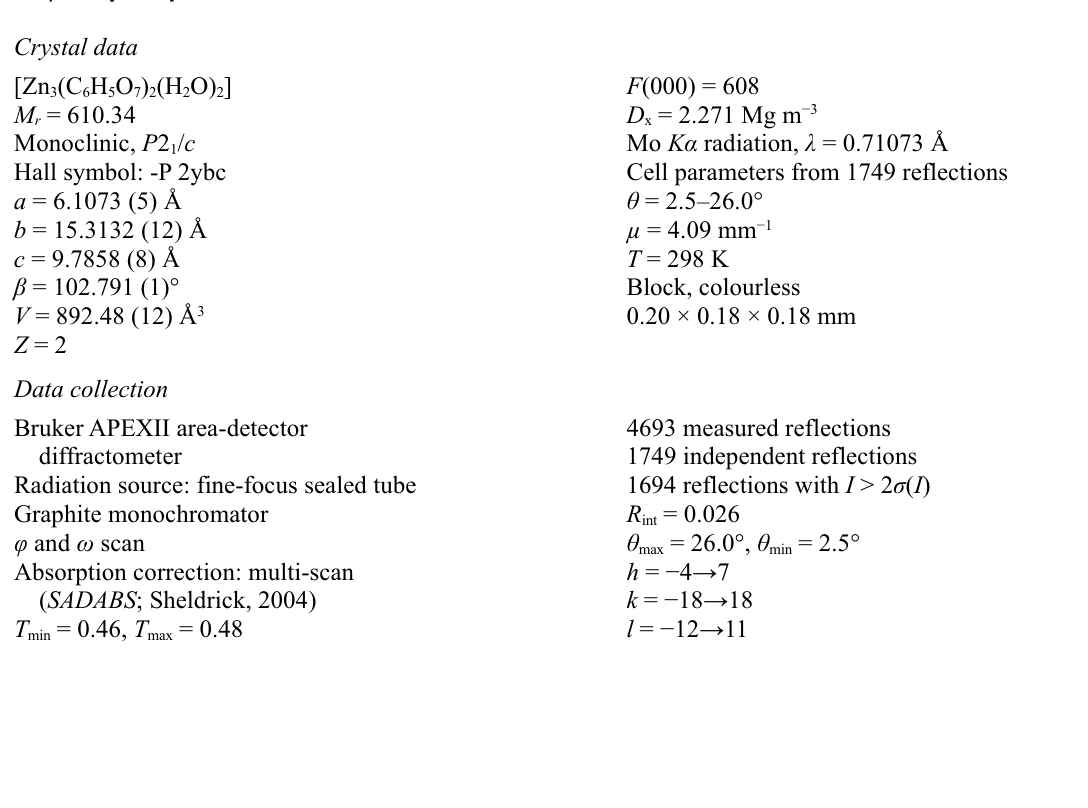
Figure 2 Two-dimensional network structure of complex (I). Colour codes: yellow, Zn1 polyhedra, pink, Zn2 polyhedra. Poly[diaquadi- µ 4